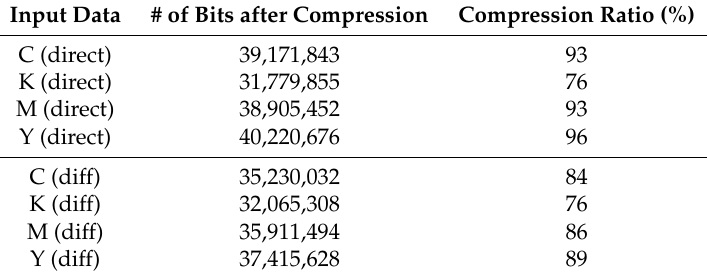
Table 1. Compression performance for applying CMYK image